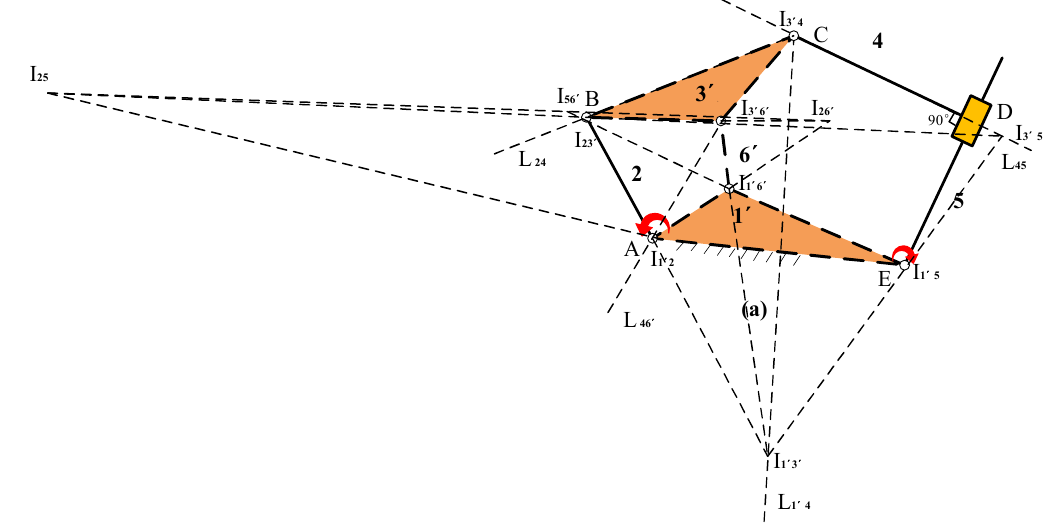
Figure 12. Instant centers of single-loop five-bar planar linkage with one prismatic joint.